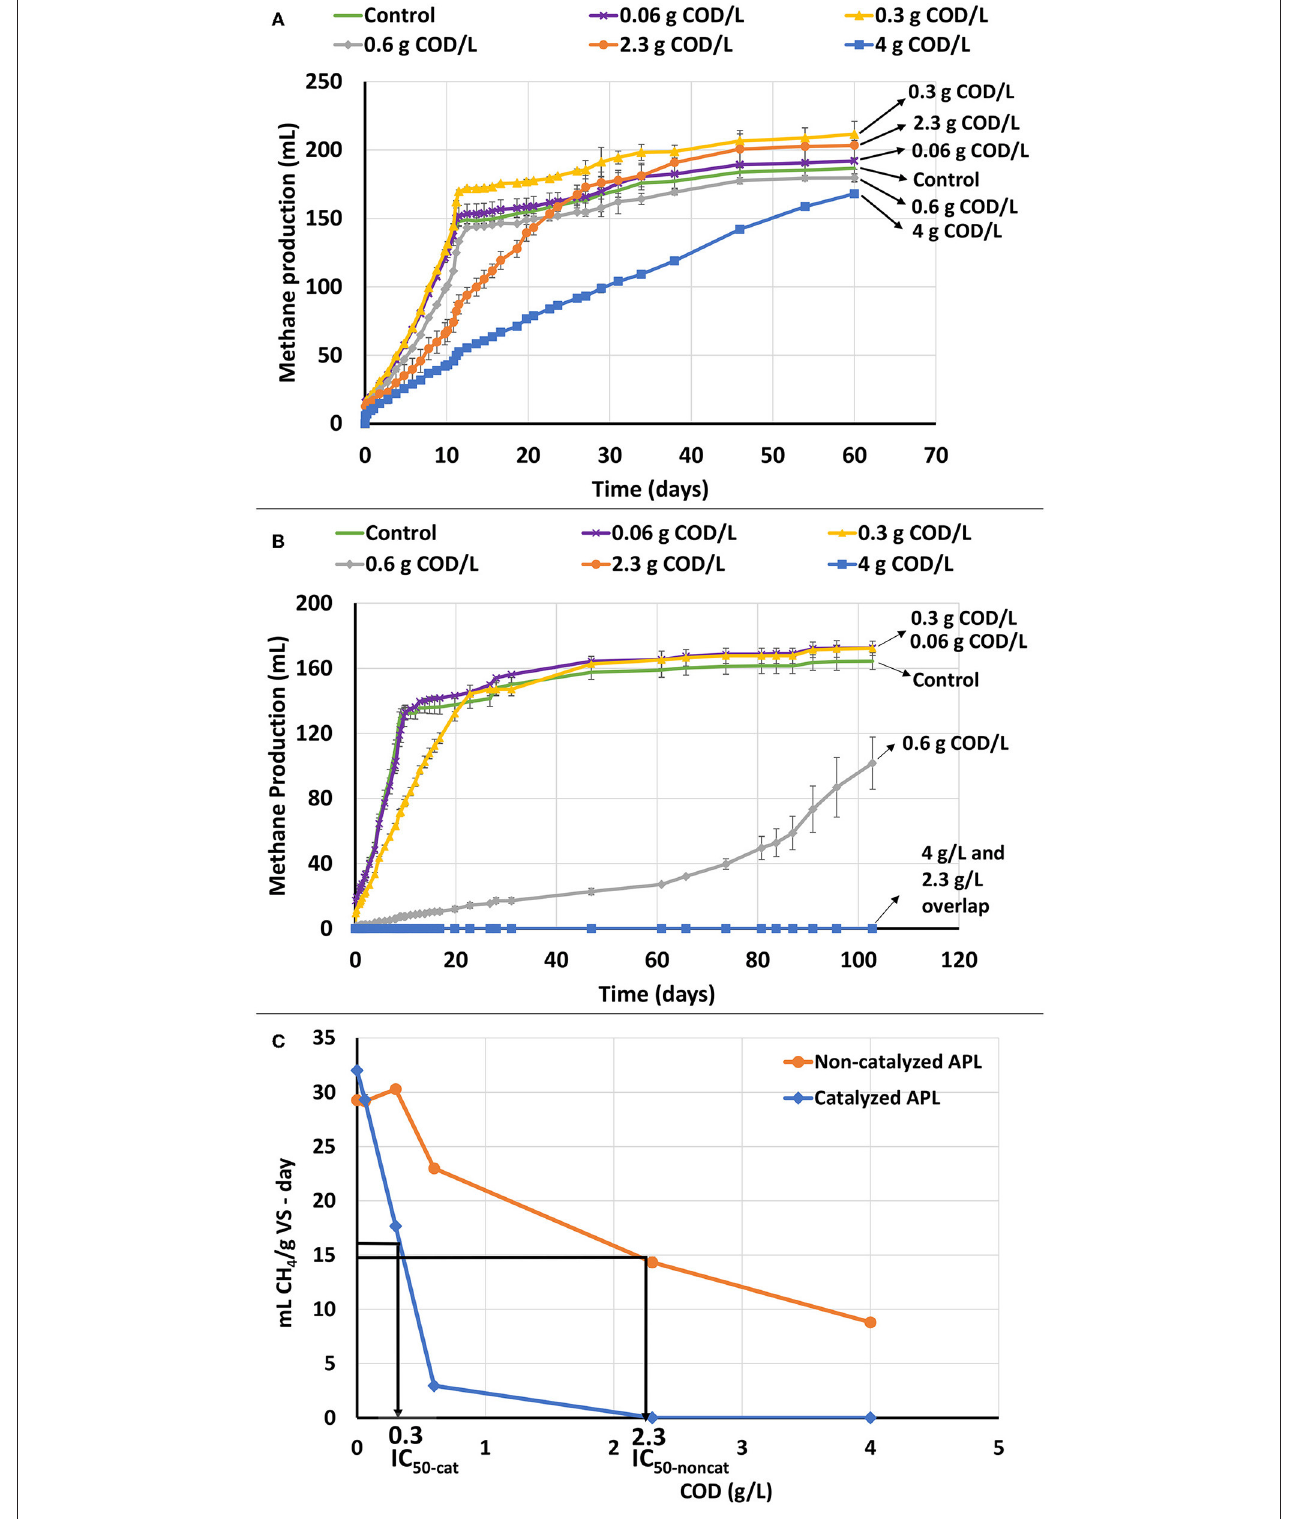
FIGURE 1 | ATA results on catalyzed and non-catalyzed APLs without air stripping. Error bars represent standard deviation among triplicates. (A) Cumulative methane production of non-catalyzed APL at different concentrations. (B) Cumulative methane production of catalyzed APL at different concentrations. (C) ATA dose-response curves based on COD for catalyzed and non-catalyzed APLs and comparison of IC 50 values between catalyzed and non-catalyzed APLs.